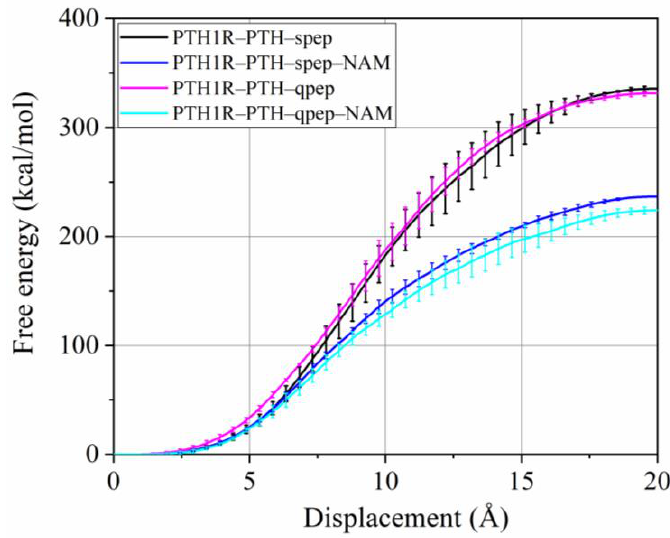
Figure 4. Residue contribution to the binding of PTH: ( A ) PTH1R – PTH – spep and PTH1R – PTH –